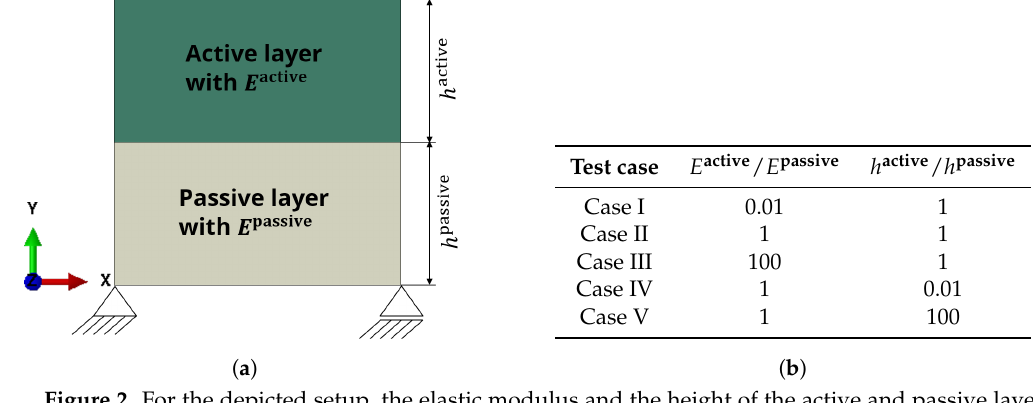
Figure 2. For the depicted setup, the elastic modulus and the height of the active and passive layer is varied to form Case I to Case V. The two-dimensional structure is fixed at the left side with a fixed bearing and at the right side with a floating bearing. ( a ) Base setup of the active–passive pairing. ( b ) Description of the